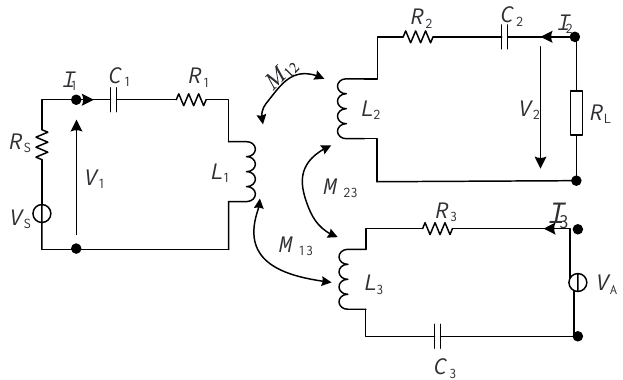
Figure 4. Equivalent circuit of WPT systems with double-coil active shielding.